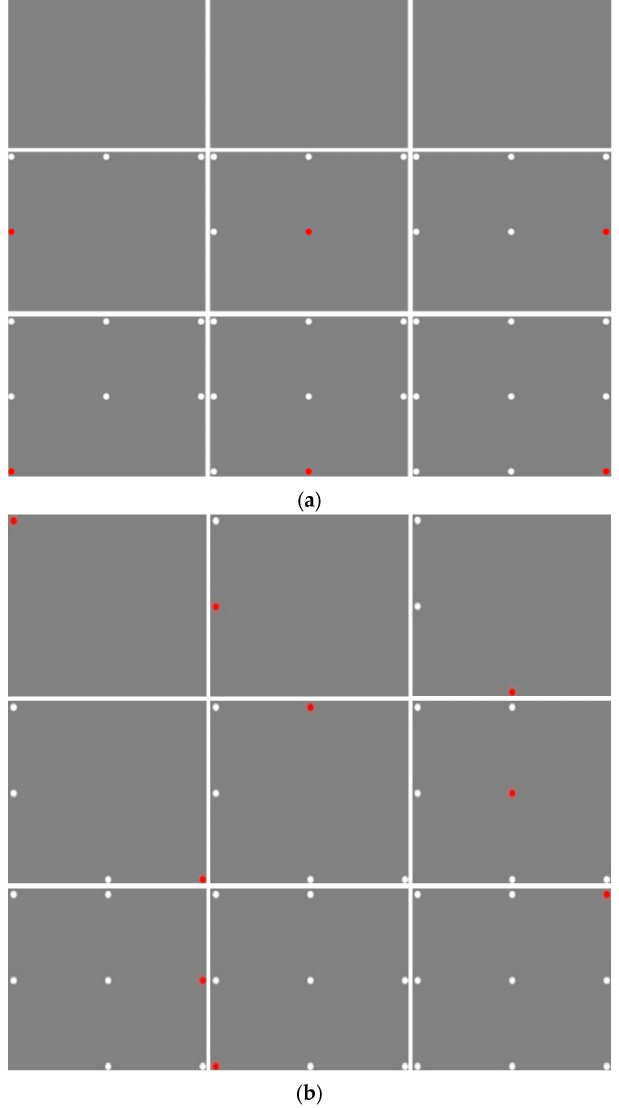
Figure 13. Marker display methods: ( a ) sequential and ( b ) random marker